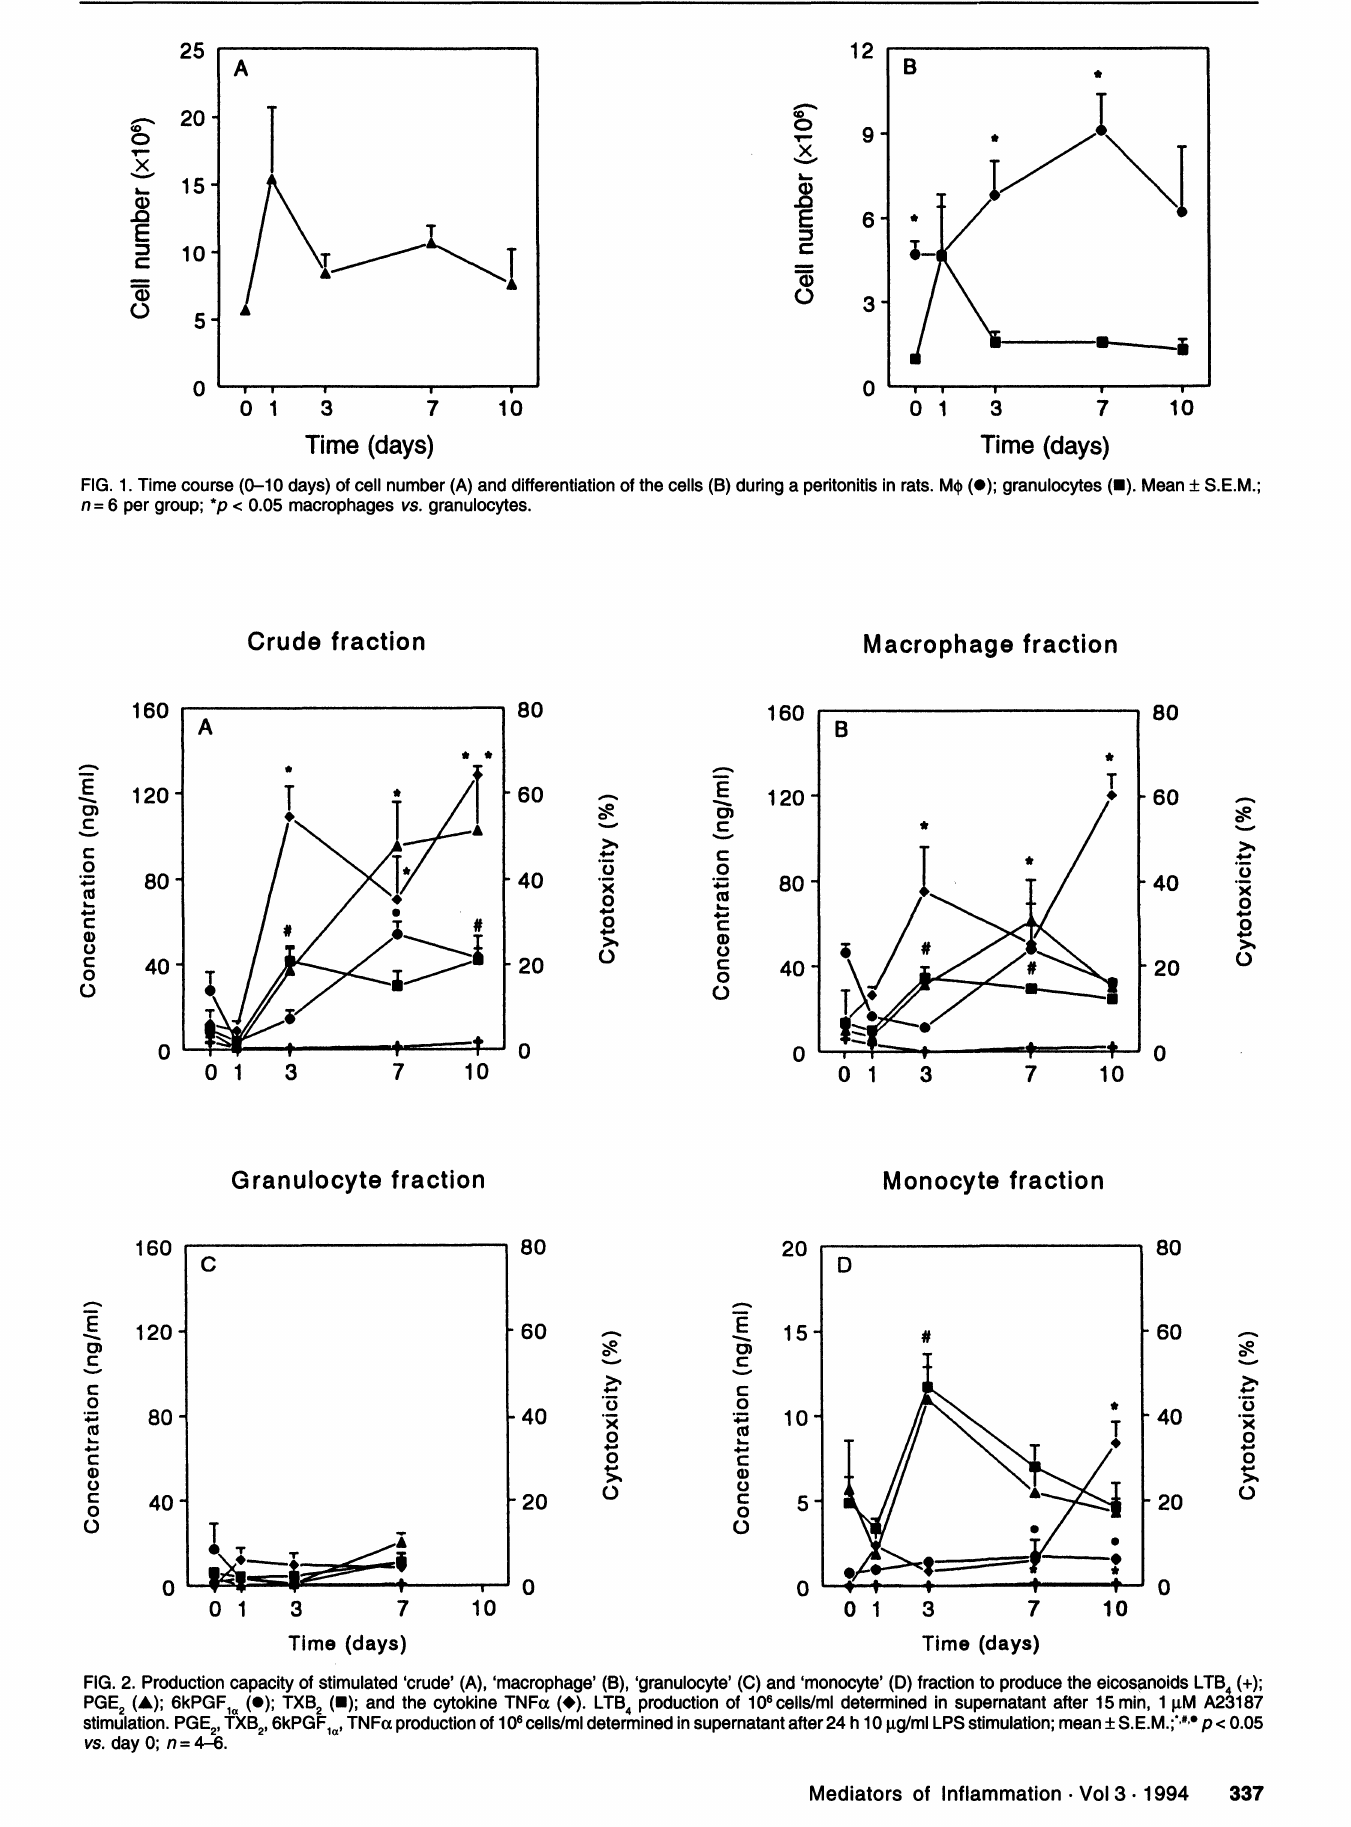
FIG. 2. Production capacity of stimulated ’crude’ (A), ’macrophage’ (B), ’granulocyte’ (C) and ’monocyte’ (D) fraction to produce the eicosanoids LTB (+); PGE (,); 6kPGFI (e); TXB2 (B); and the cytokine TNFx (e). LTB4 production of 10cells/ml determined in supernatant after 15 min, IM A23187 stimulation. PGE v TXB v 6kPGFI, TNF(x production of 106 cells/ml determined in supernatant after 24 h 10 lg/ml LPS stimulation; mean + S.E.M.; ",#,= p < 0.05 vs. day 0; n